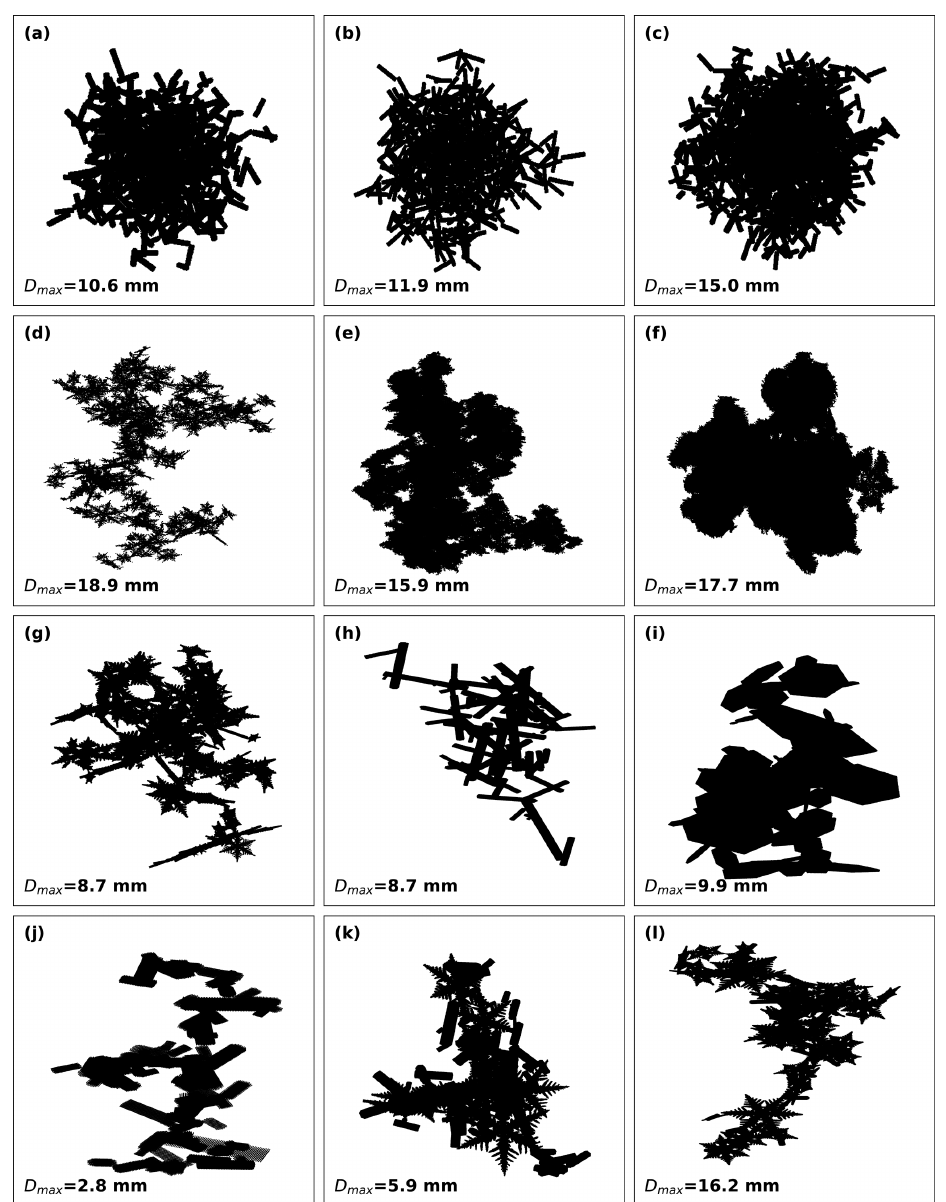
Figure 3. Example of the different aggregates available in snowScatt. The first row shows aggregates described in Ori et al. (2014). The second row shows the Leinonen and Szyrmer (2015) aggregates, with different degrees of riming: panel (d) is unrimed, panel (e) has 0.5kgm − 2 ELWP (LS15B05), and panel (f) has 1.0kgm − 2 ELWP (LS15B10). The third row shows examples taken from the Cologne aggregate Ensemble (CaE), wherein the aggregate in (g) consists of dendrites, (h) needles, and (i) plates. The fourth row gives examples of the CaE mixture, with different numbers of columns and dendrites